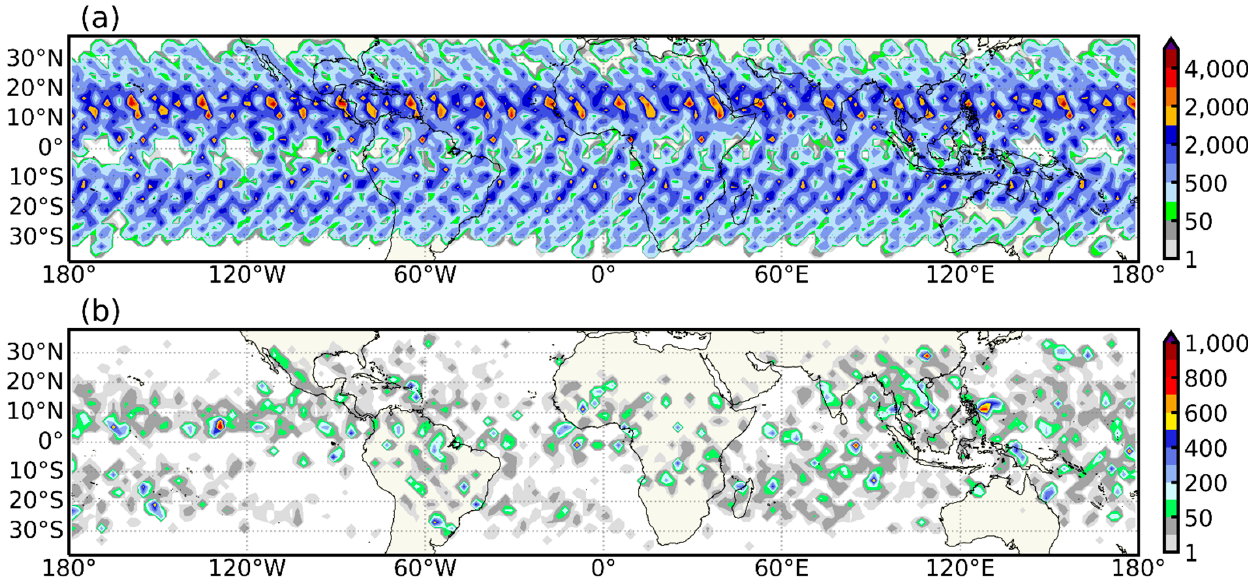
Figure 2. Global distribution of coincident events resampled to a spatial resolution of 2° × 2°. ( a ) All coincident events (with and without surface precipitation); ( b ) coincident Topht20s (with surface precipitation).